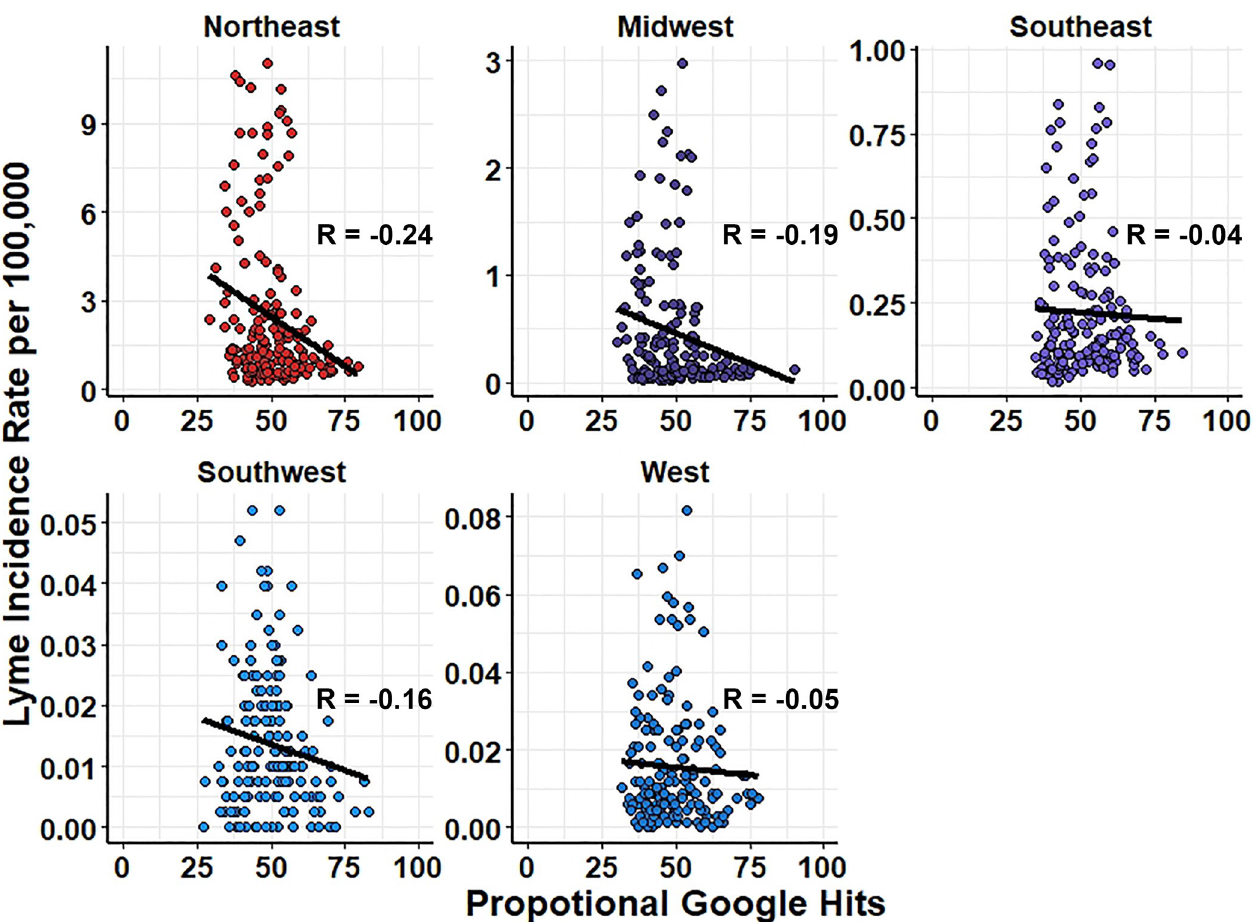
Fig 4. Negative bivariate correlation of fever to Lyme disease incidence for all regions of the United States. Correlation calculated using Pearson method with independent variable as proportional Google hits for each term and dependent variable Lyme Incidence per 100,000 for each region.